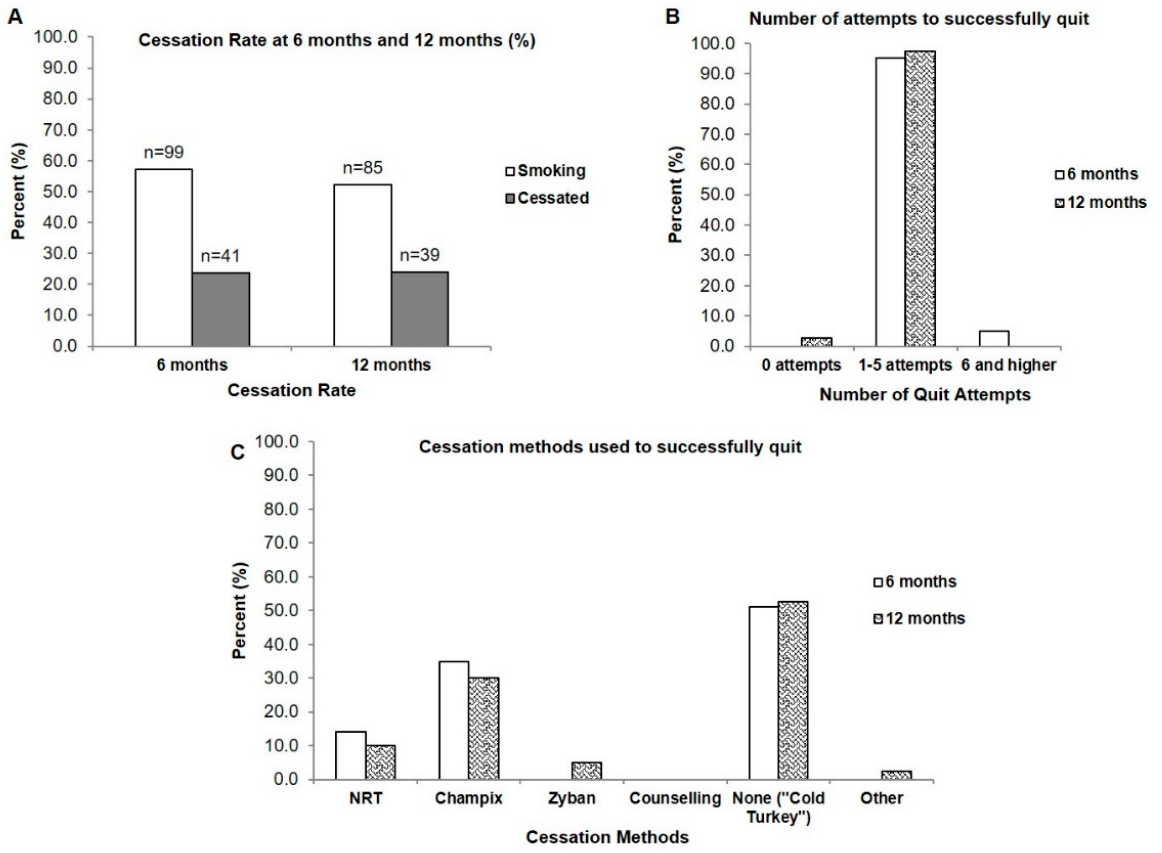
Figure 1. Cessation rate, number of quit attempts, and cessation methods of those currently smoking who cessated after presentation of a clinical tobacco intervention. ( A ) Cessation rate at 6- and 12-months ( B ) Number of quit attempts required by those who were smoking for successful cessation ( n = 41 at 6 months; n = 39 at 12 months) ( C ) Cessation methods used to quit ( n = 41 at 6 months; n = 39 at 12